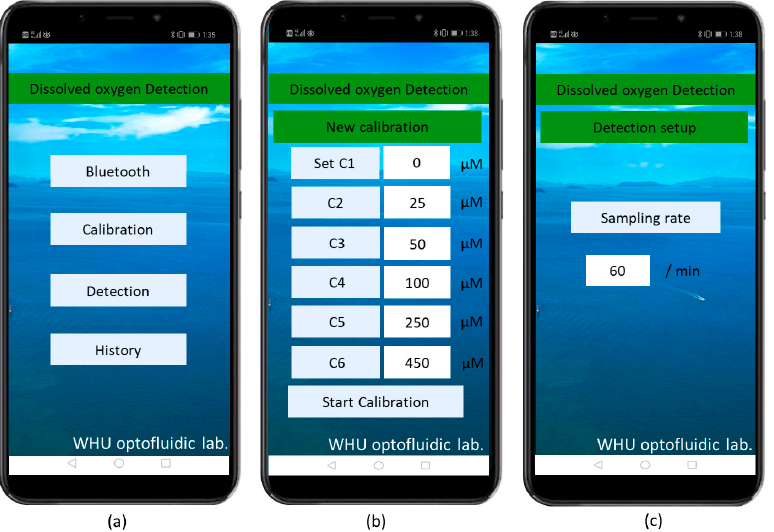
Figure A1. Simplified Jablonski diagram shows phosphorescent generation and main energy tran- sitions during measurement. S 0 : Ground state of the phosphor; S 1 : First excited singlet states of the phosphor; S2: Second excited singlet states of the phosphor; T 1 : The excited triplet state of the phosphor; IC: Internal Conversion; ISC: Inter-system Crossing.